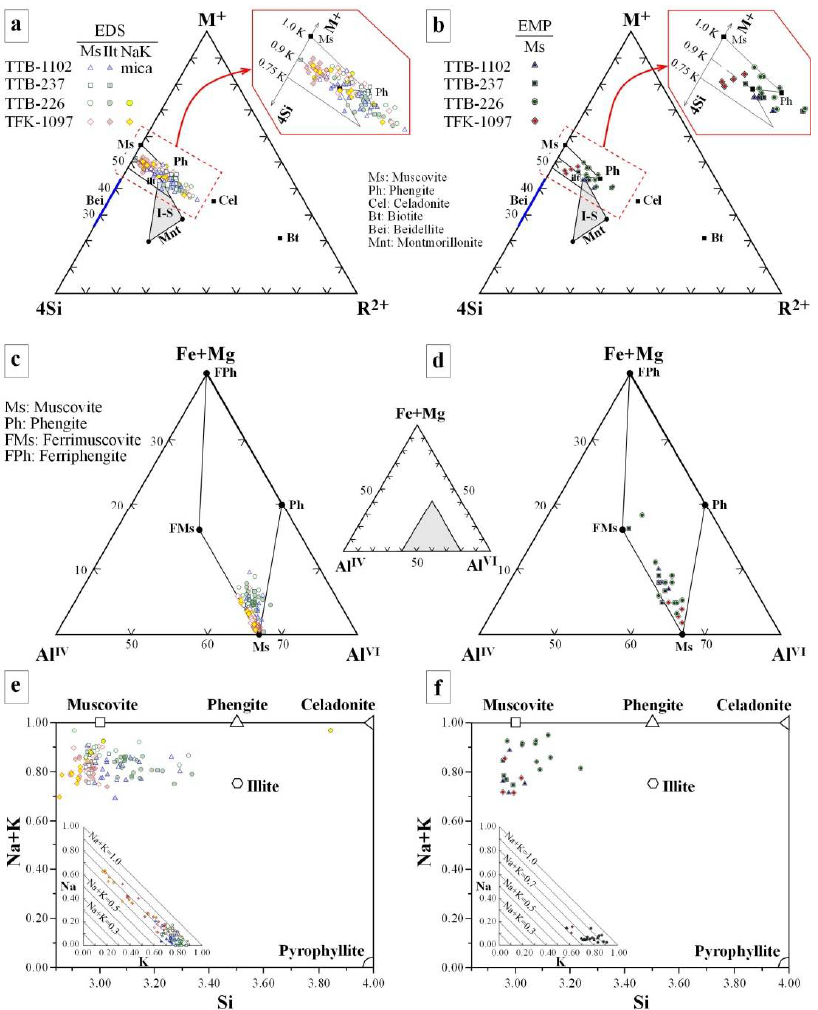
Figure 13. The compositional distributions of illites/micas. ( a , b ) M + –4Si–R 2+ triangular diagram